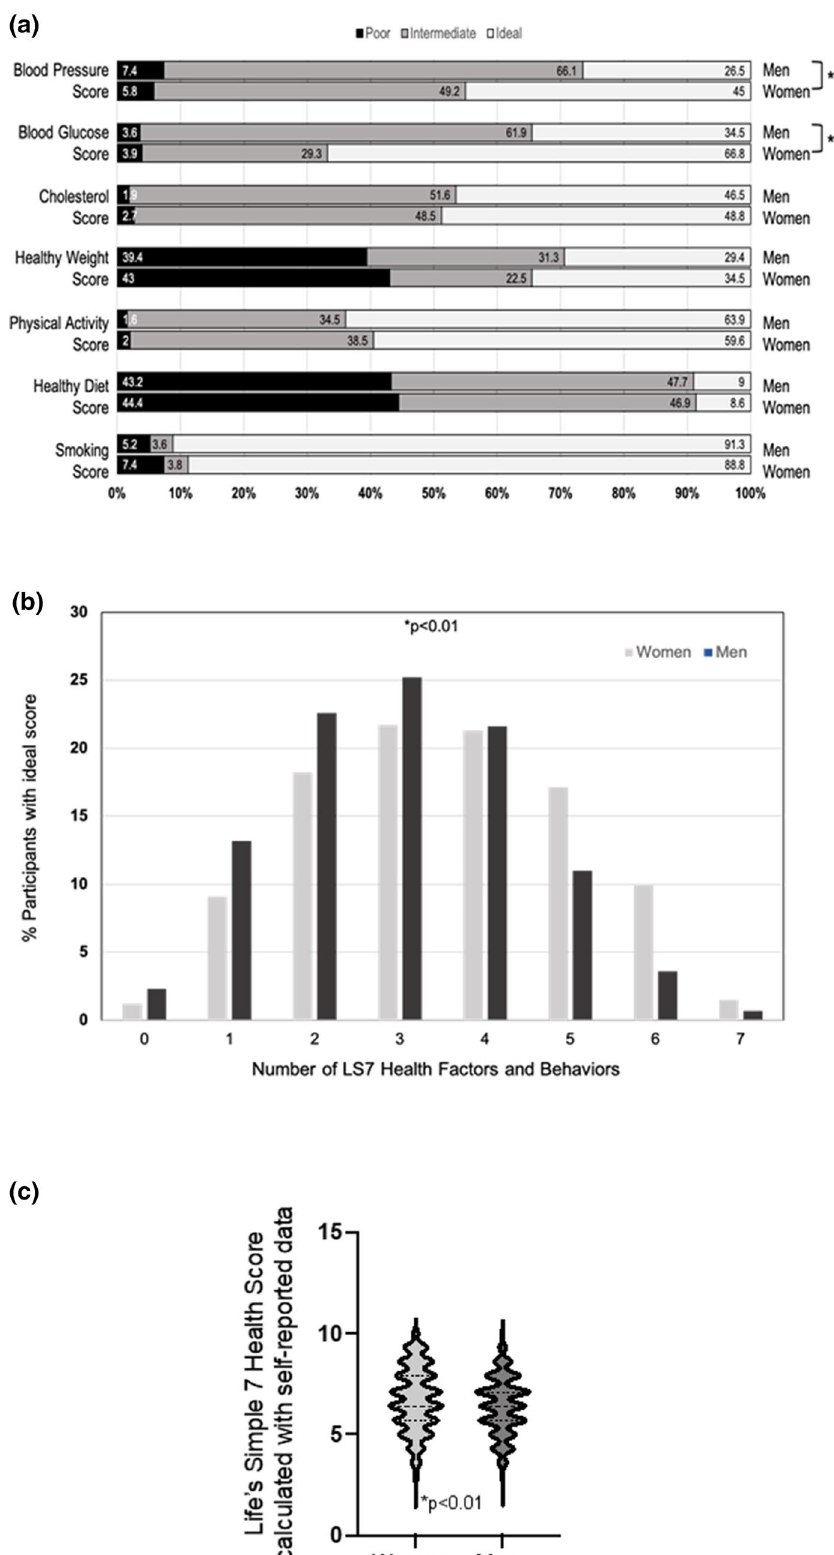
Figure 1. Gender differences in Life’s Simple 7 health factors and behaviors. ( a ) The percentage of poor, intermediate, and ideal scores for women (n = 1251) and men (n = 310) for each of the 7 health factors and behaviors assessed in Life’s Simple 7. *p < 0.01. ( b ) The number of Life’s Simple 7 health and behavior categories for which participants achieved an ideal score. Data are shown for women and men. ( c ) Violin plots of the Life’s Simple 7 Health Score calculated using self-reported data for women compared to men. Median and quartiles are represented by dashed lines. *p <